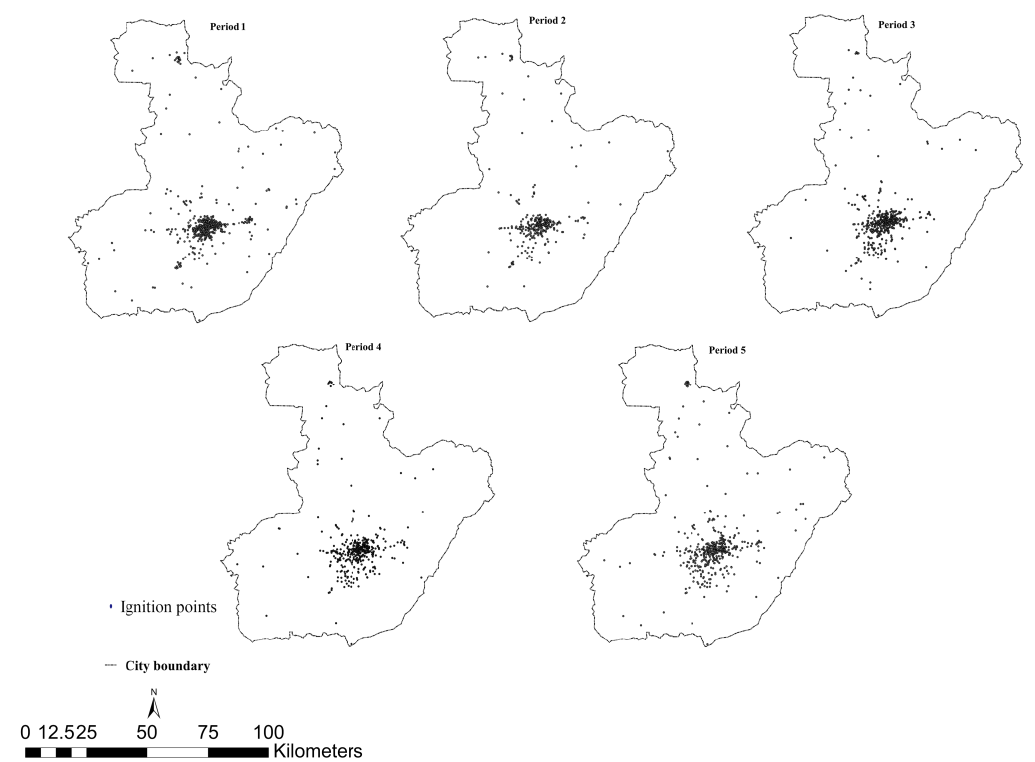
Figure 5. Ignition points between 2002 and 2010, divided into five time periods.